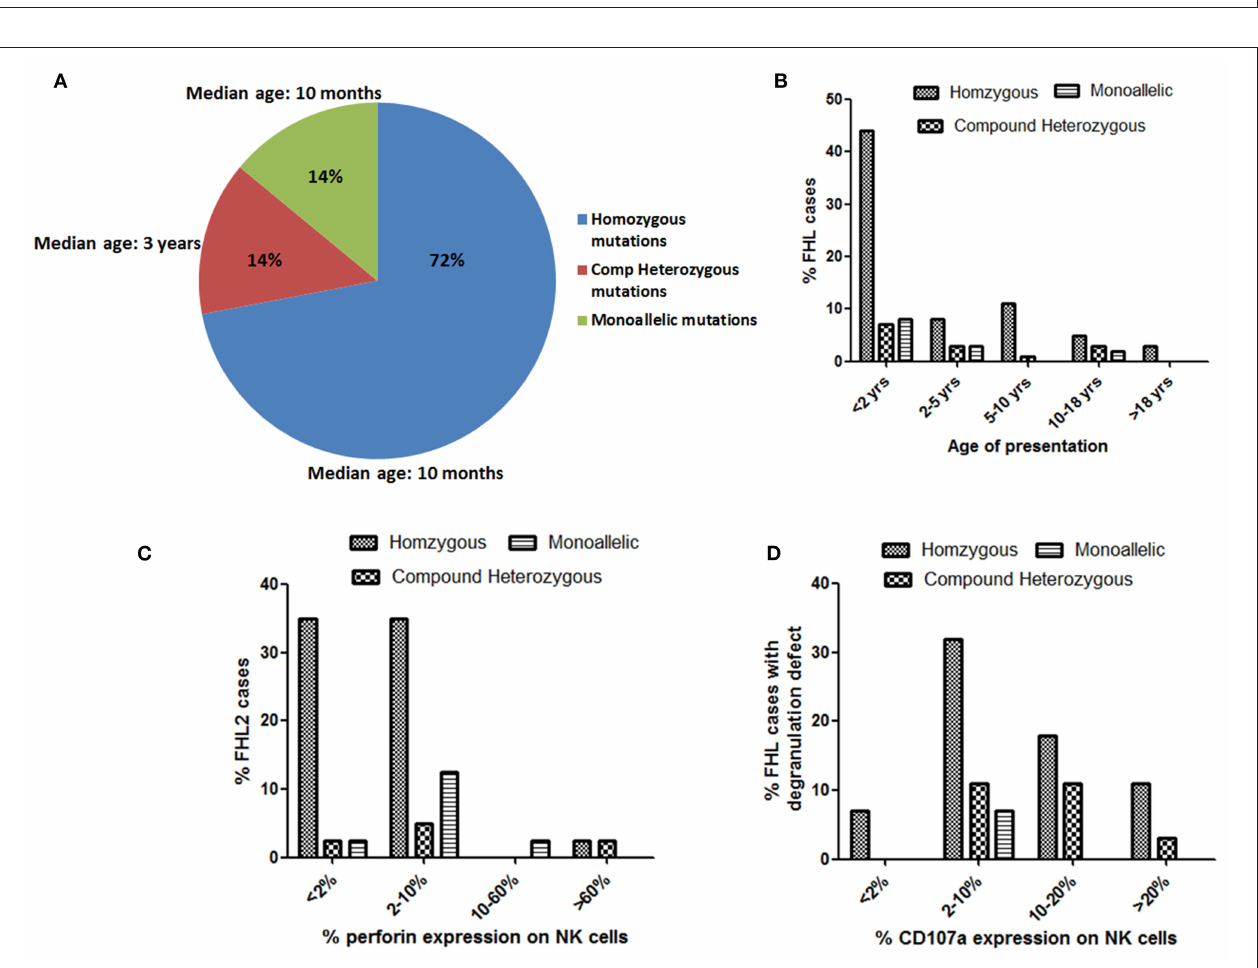
In accordance with previous studies (1, 3, 9, 10, 13), 84% of our FHL patients were either FHL2 or FHL3 (50 and 35%, respectively); while the remaining 16% were FHL4 and FHL5 patients. Also as reported in various retrospective